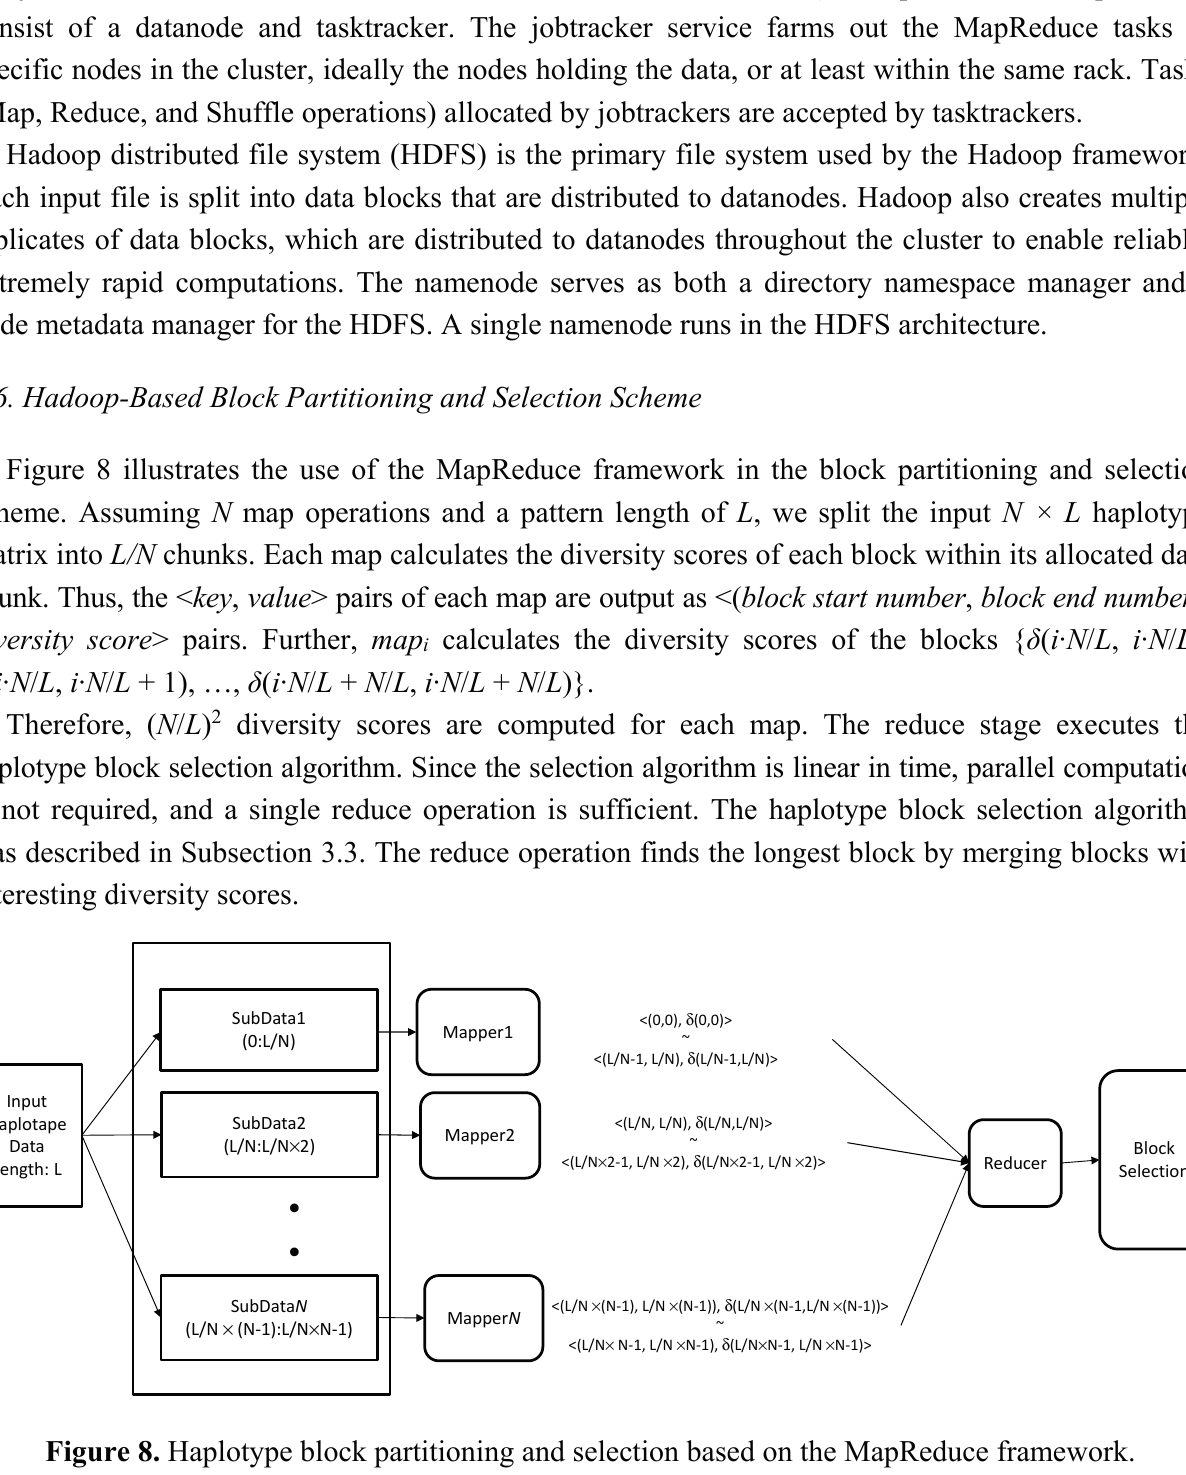
Figure 8. Haplotype block partitioning and selection based on the MapReduce